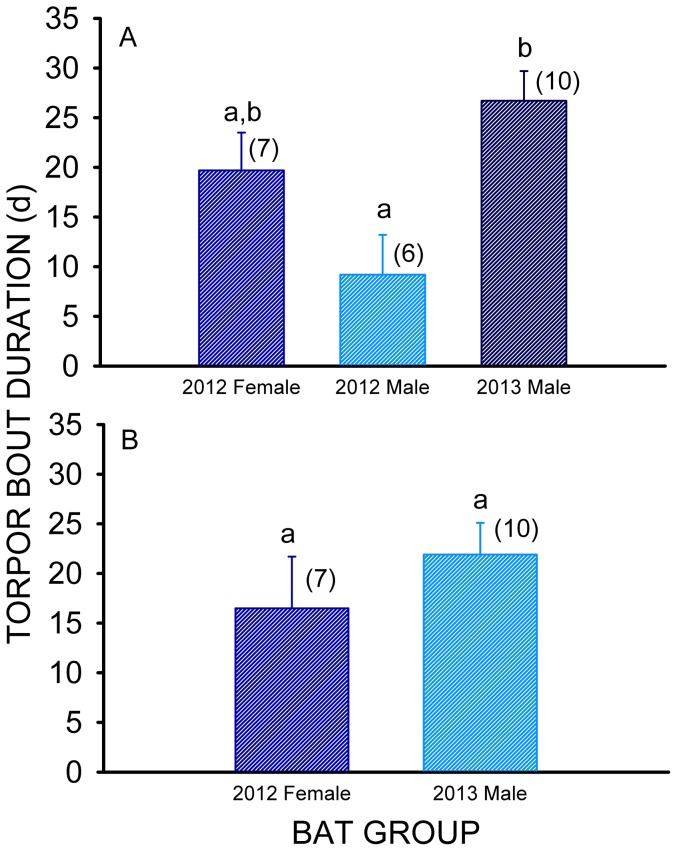
Mean (+ SE) durations of natural torpor bouts during hibernation by E. fuscus.First natural torpor bouts observed that occurred after normal arousal episodes during 2012 and 2013 (A) and second natural torpor bouts observed that occurred after normal arousal episodes during 2012 and 2013 (B). Means within the same torpor bout category sharing a common lower-case letter are not significantly different at the p<0.05 level, sample sizes (N) are given in parentheses.